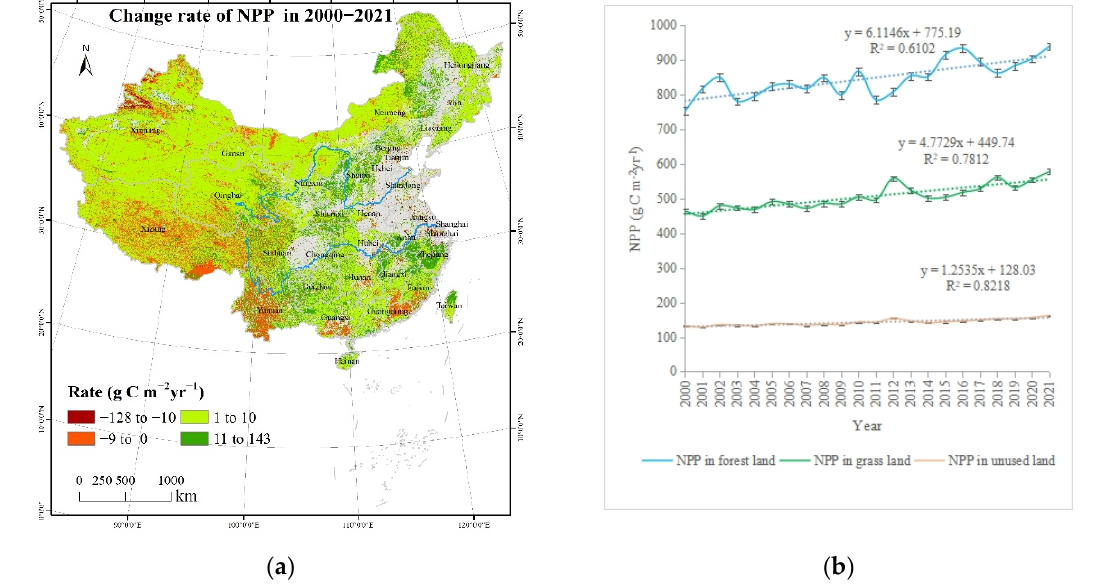
Figure 2. Change rate of NPP at 1 km × 1 km grid cell ( a ), and the average change rate in forest land, grass land, and unused land ( b ) in 2000 − 2021. grass land, and unused land ( b ) in